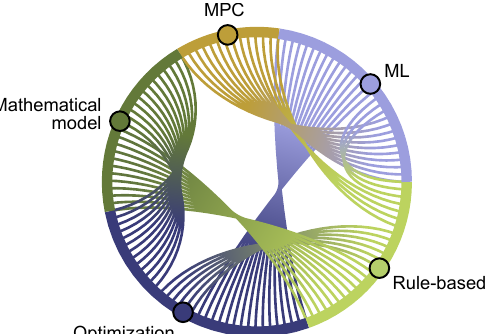
Figure 10. Use of methodology combinations in the analyzed papers.